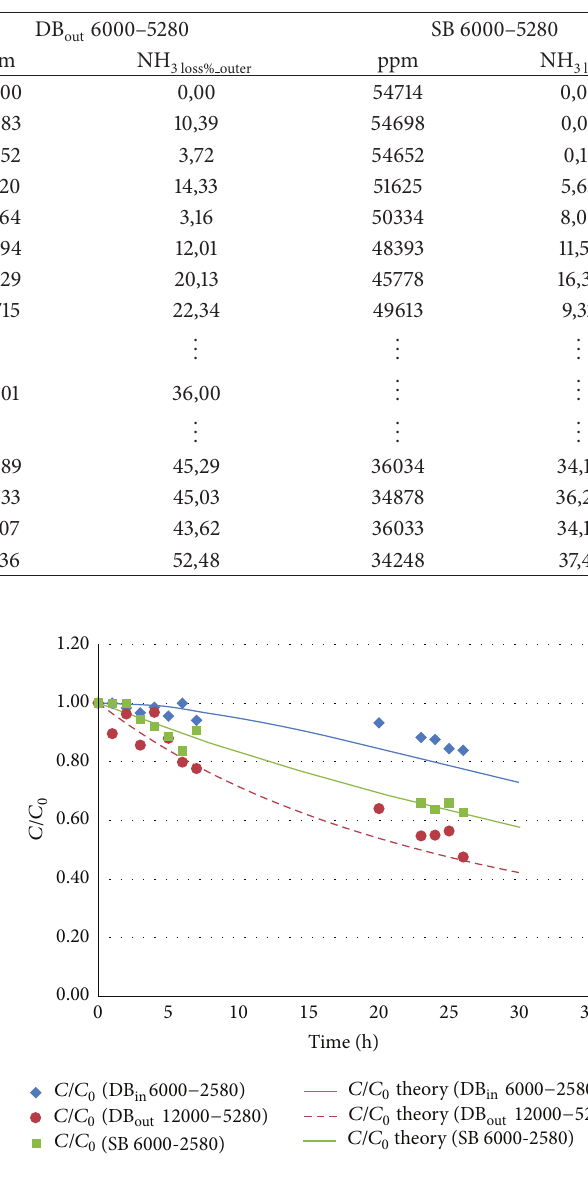
6000–2580) have 𝑉 𝑛 = in